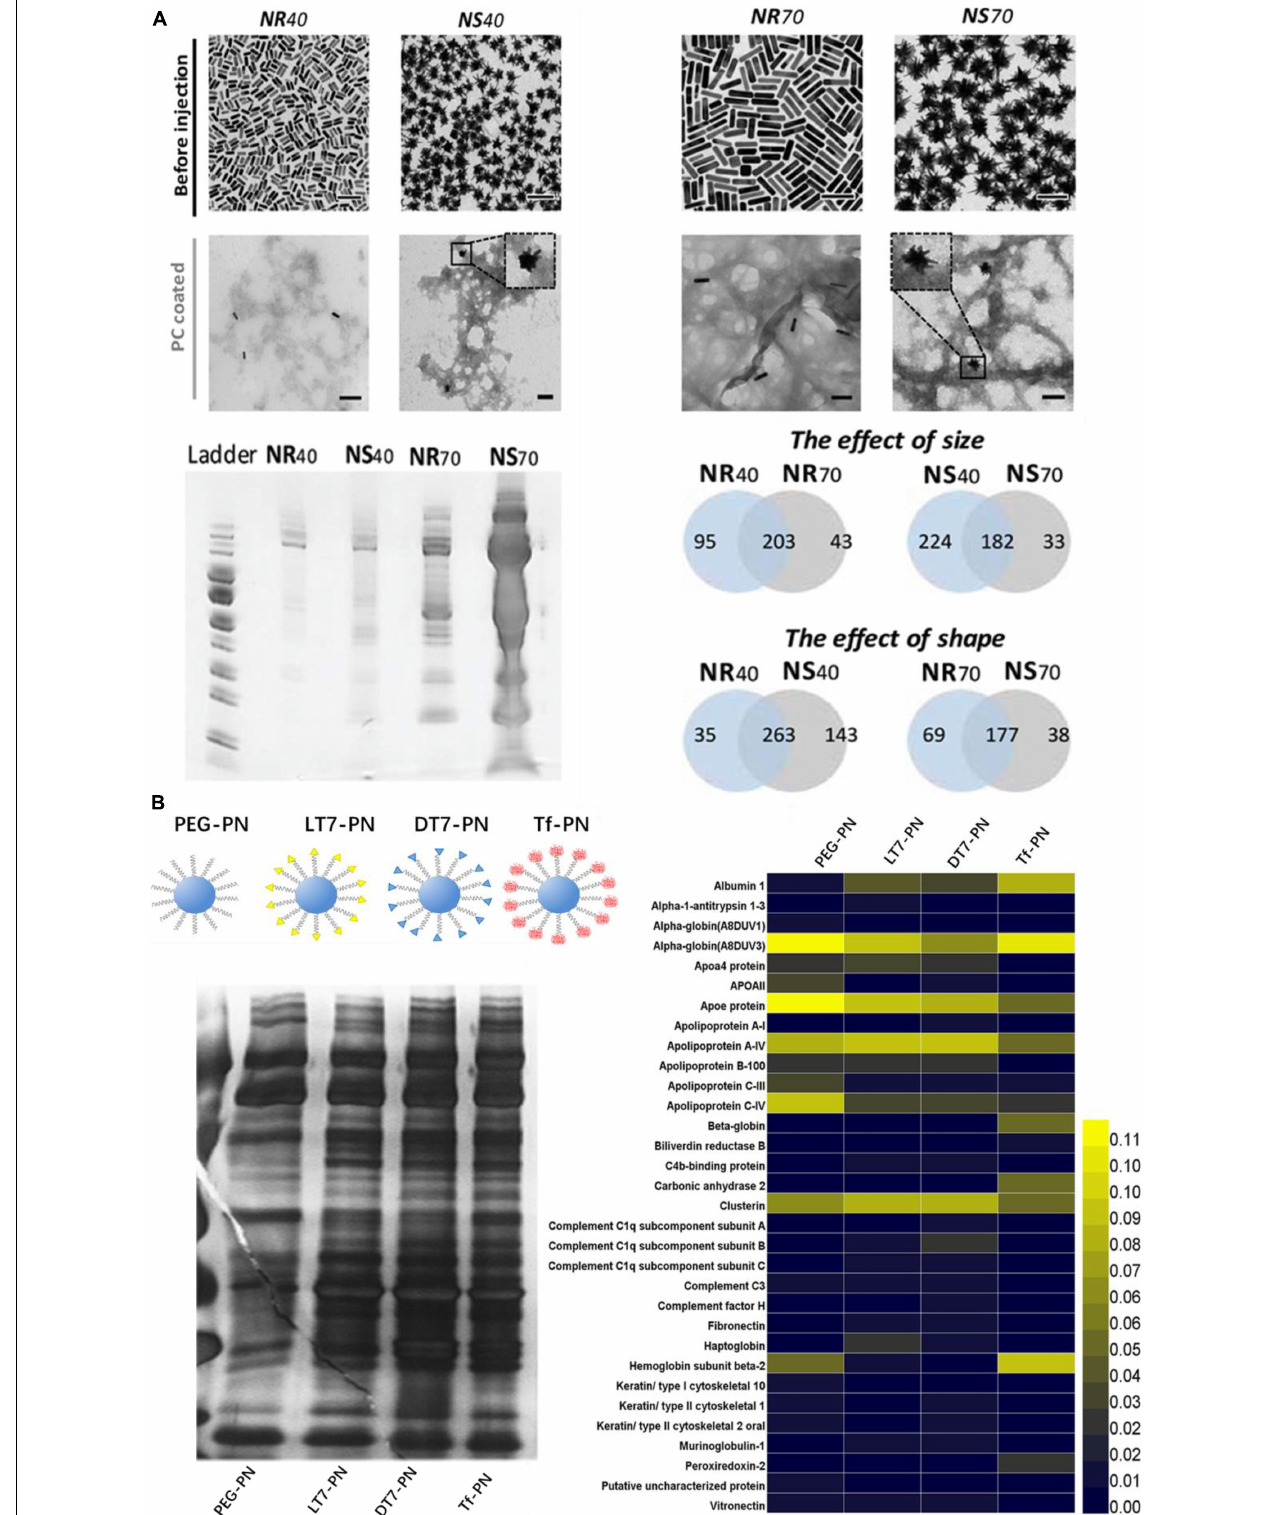
FIGURE 3 | Physicochemical properties of ENPs affect the in vivo PC formation. (A) TEM images of AuNPs with different size and shape and they adsorbed protein amounts and types in vivo . Adapted with permission from García-Álvarez et al. (2018). (B) Four types of polystyrene NPs modified with PEG and Tf receptor (TfR)-targeting ligands (LT7, DT7, and Tf) and their corresponding in vivo PC formation. Adapted with permission from Zhang et al. (2018).